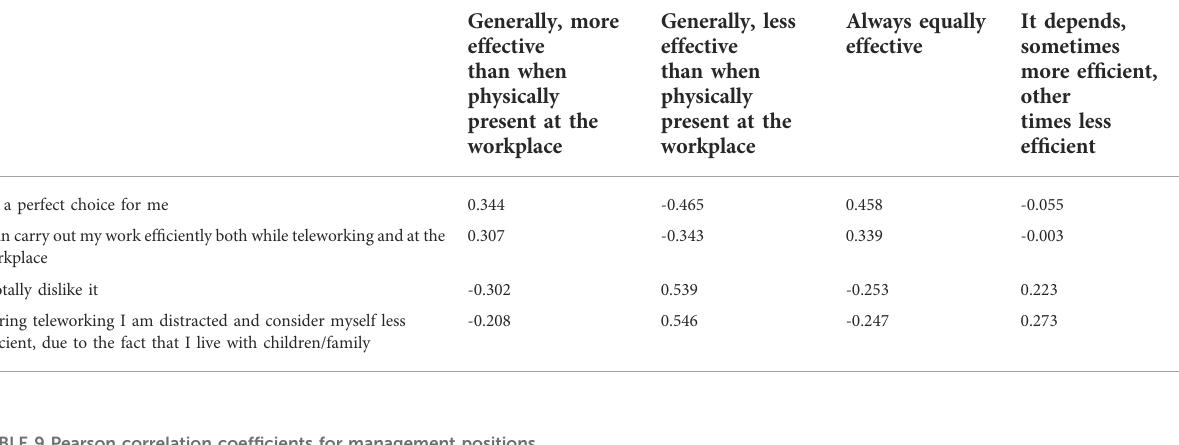
TABLE 9 Pearson correlation coef fi cients for management